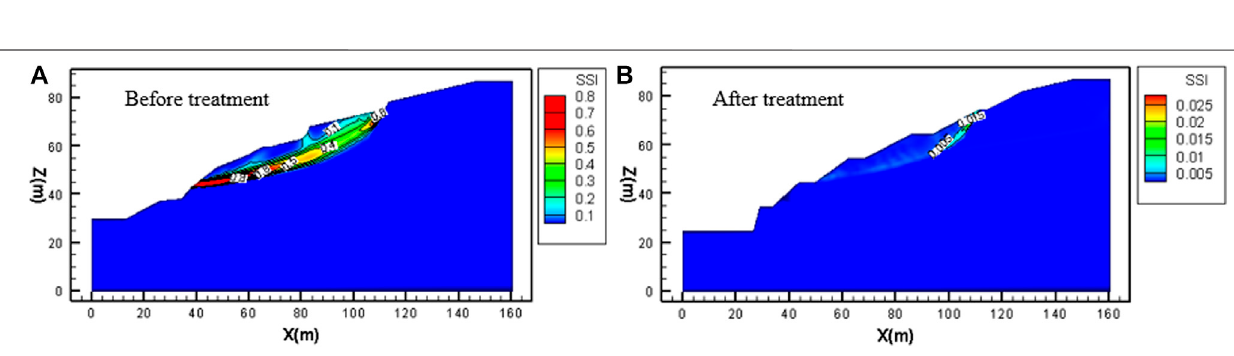
Frontiers in Earth Science |